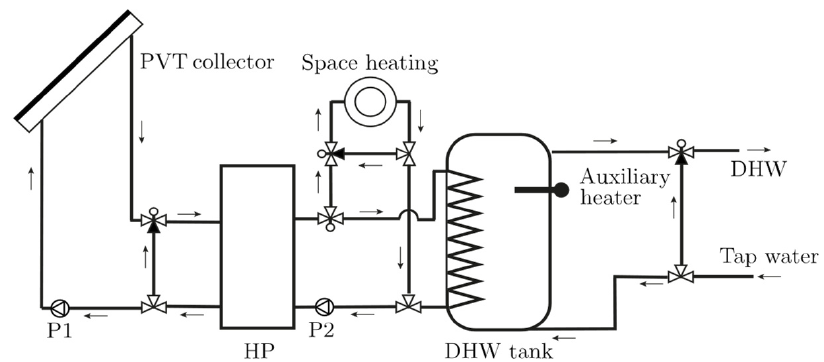
Figure 1. Hydraulic scheme of the PVT-HP system.